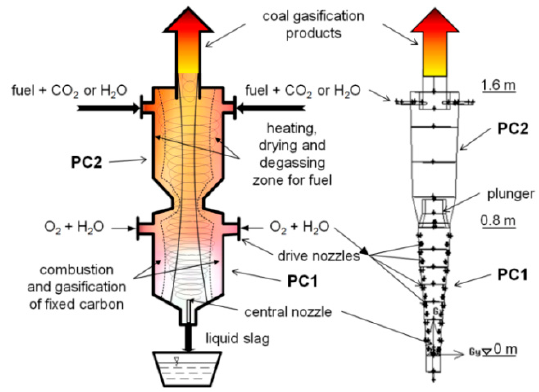
Figure 1. The idea and sketch of the cyclone furnace geometry [11,13].